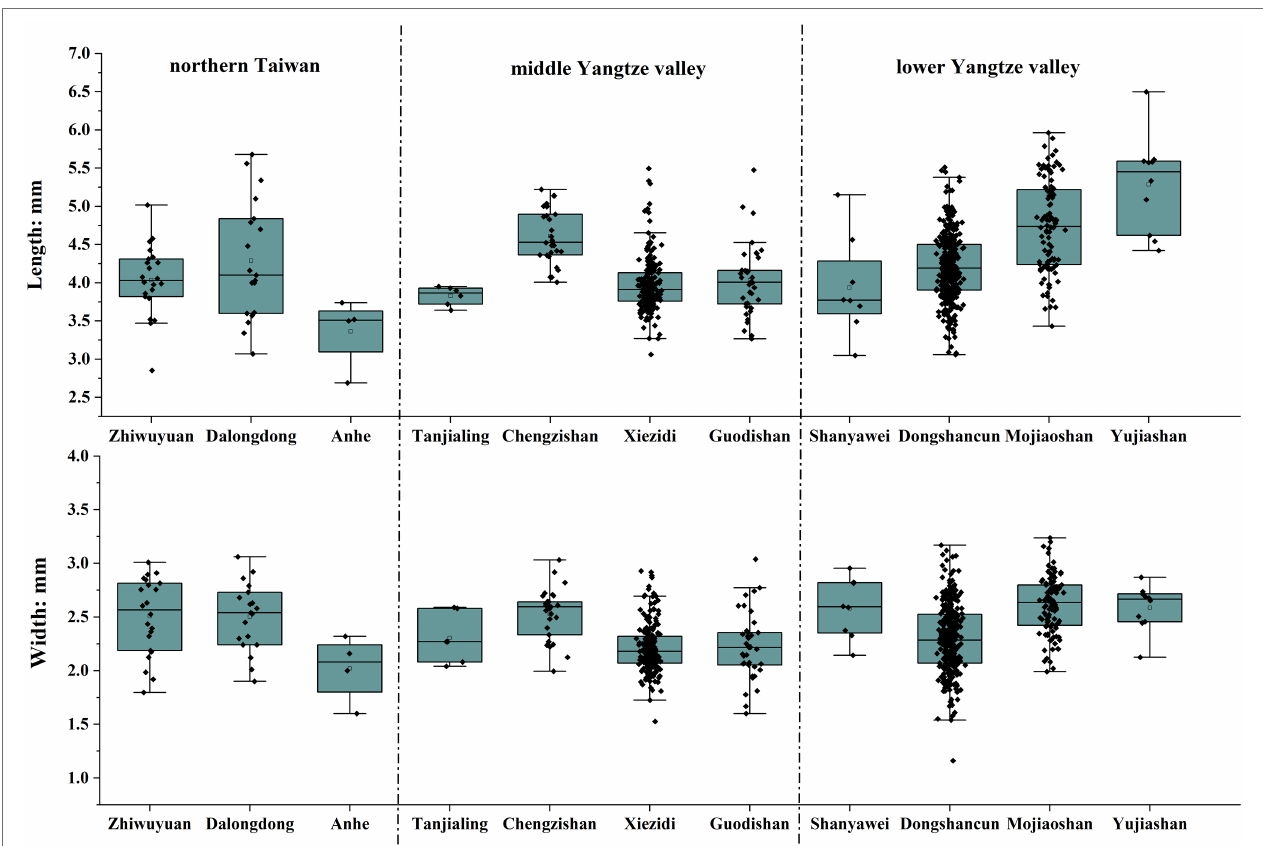
FIGURE 9 | Comparison of length and width of rice grains from Zhiwuyuan, Dalongdong, Anhe, and other late Neolithic sites ( ca. 4,800–4,200 cal. BP) in the middle and lower Yangtze